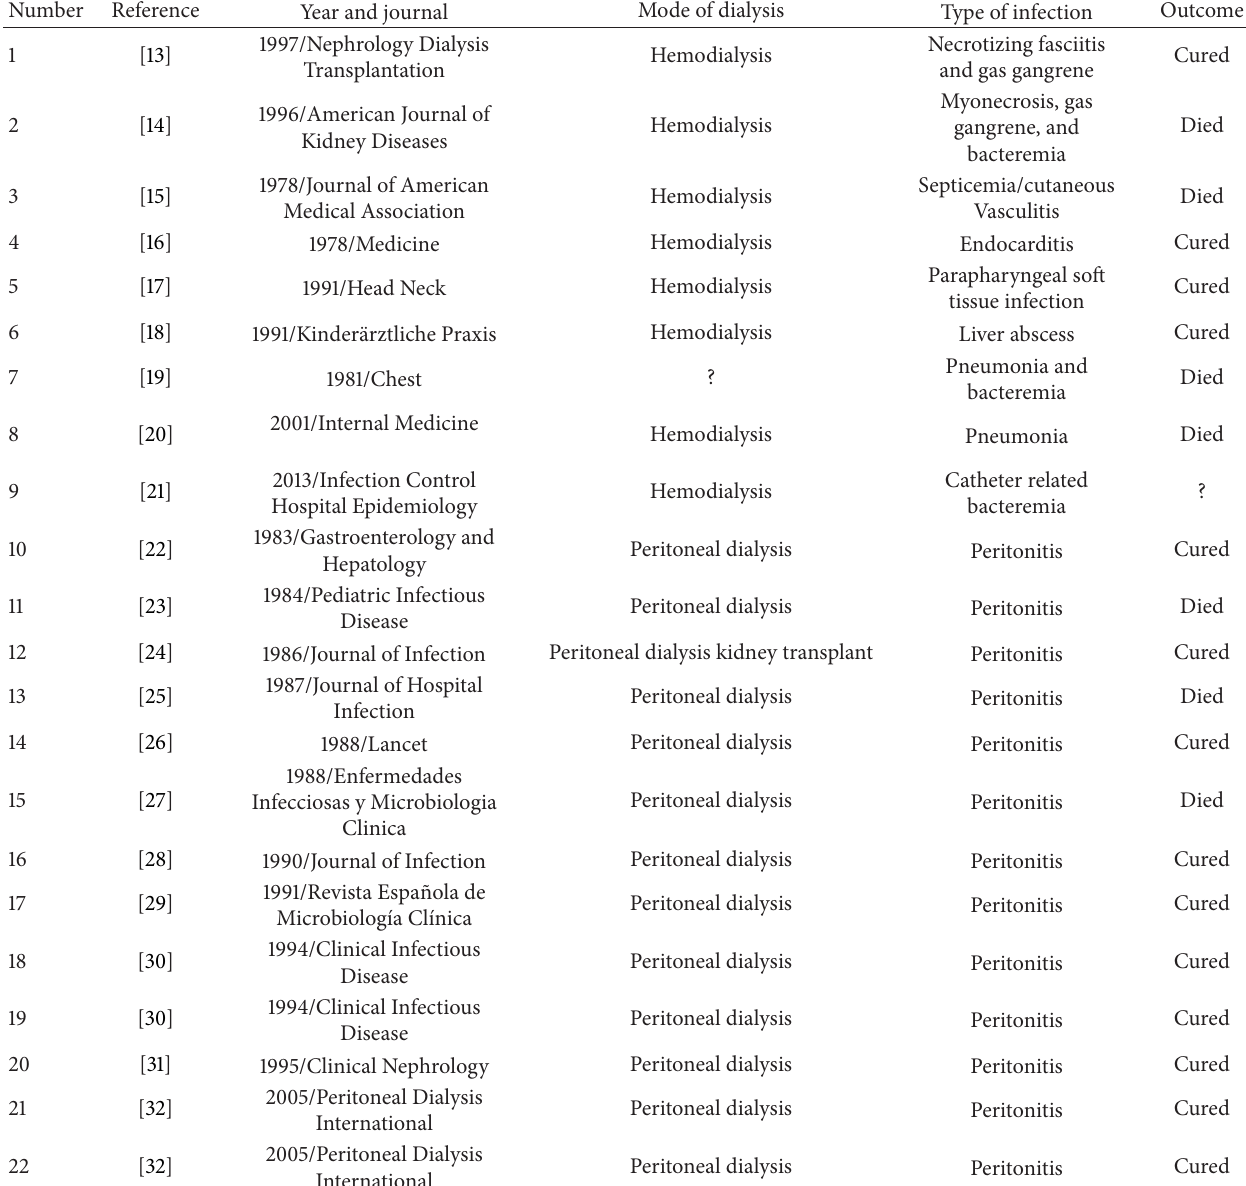
Table 1: Summary of case reports of aeromonas infections in chronic kidney disease